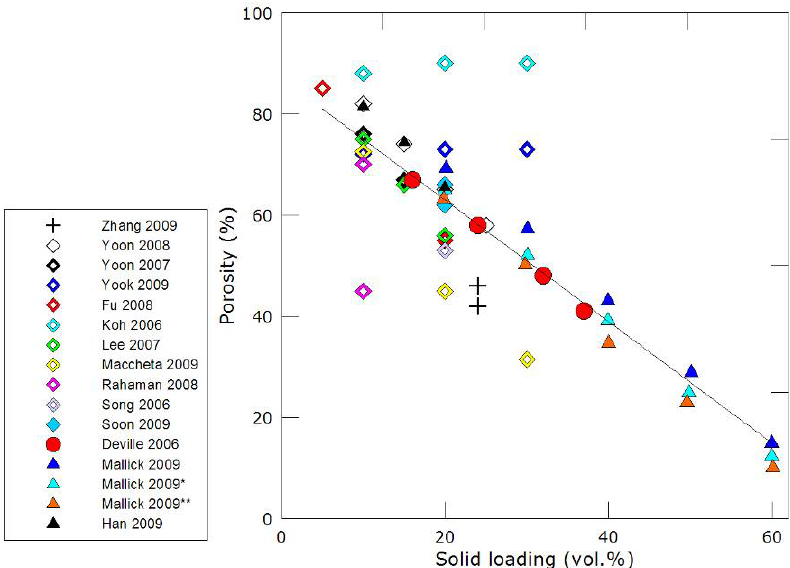
Figure 6. Porosity versus solid loading for freeze-cast porous ceramic materials [18–